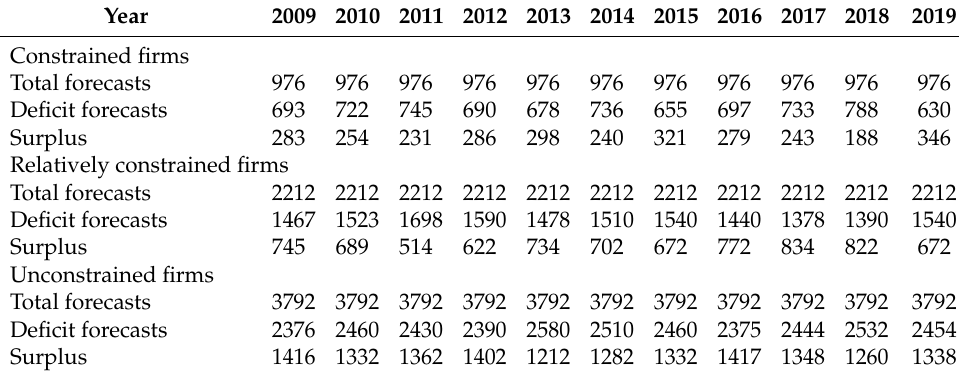
Table 3. Measurement of managerial